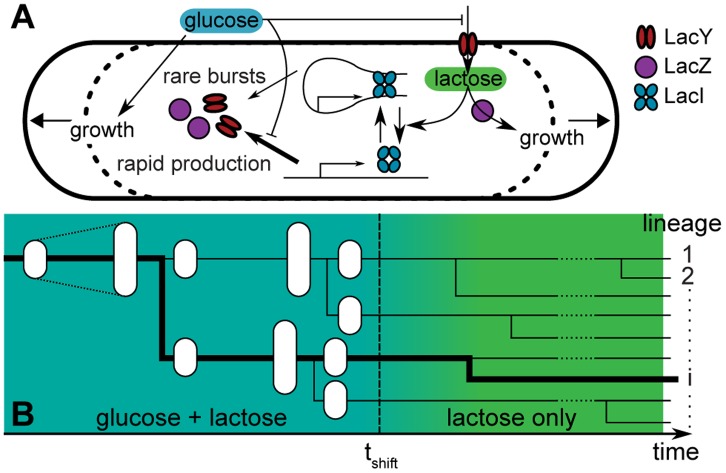
Stochastic model.(A) Within each cell the concentrations of lactose, LacYZ and LacI are simulated, as well as the operator state. Lactose imported from the environment or glucose lead to cell growth. (B) Each cell is simulated until it reaches a specified length, at which point it divides to produce two daughter cells. The proteins of the parent cell are partitioned randomly between the two daughters. The daughters are then simulated until their subsequent division. Growth and fluorescence recovery times (TF and Tµ) are extracted from the reconstructed cell lineages.